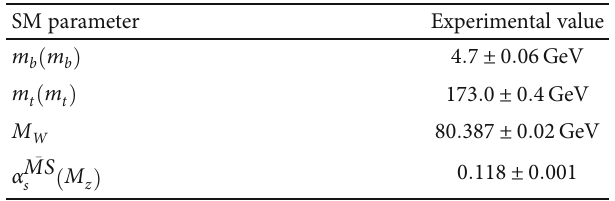
Table 1: Experimental values of Standard Model input parameters